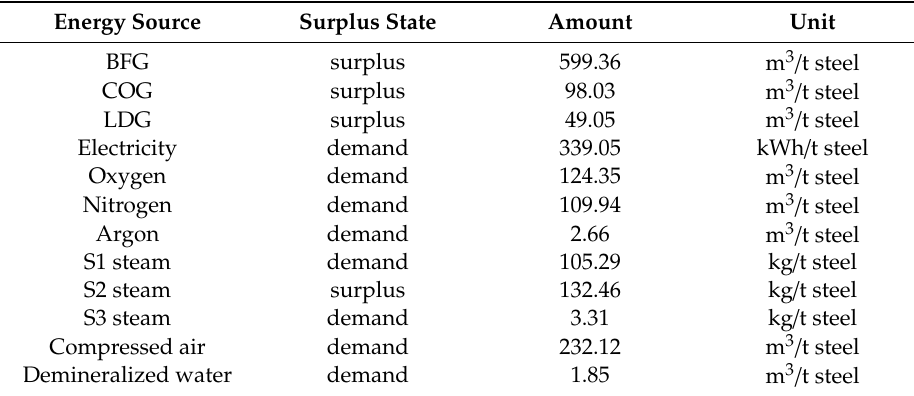
Table 2. The surplus or demand amounts of the energy